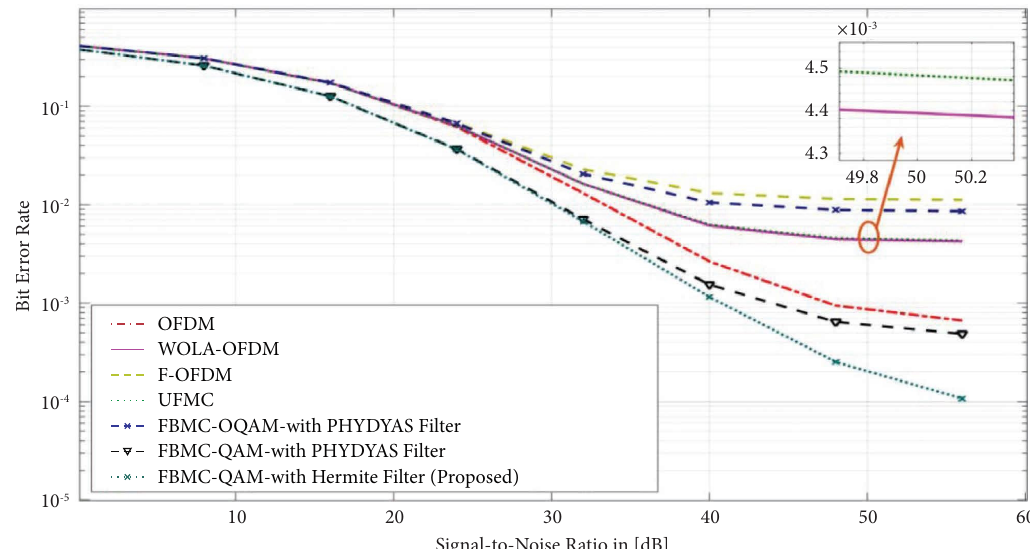
Figure 16: Bit error rate performance of diferent multicarrier modulation techniques for Pedestrian B channel model at 256 QAM.